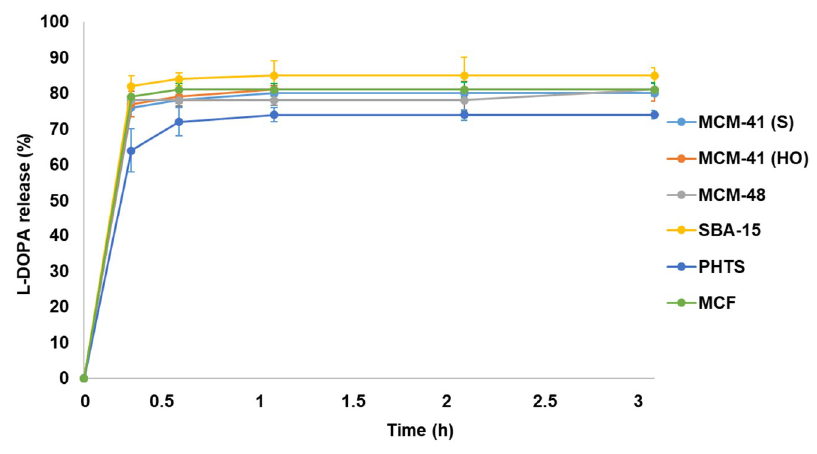
Figure 10. The L-DOPA drug release profiles for all six types of mesoporous silica particles.